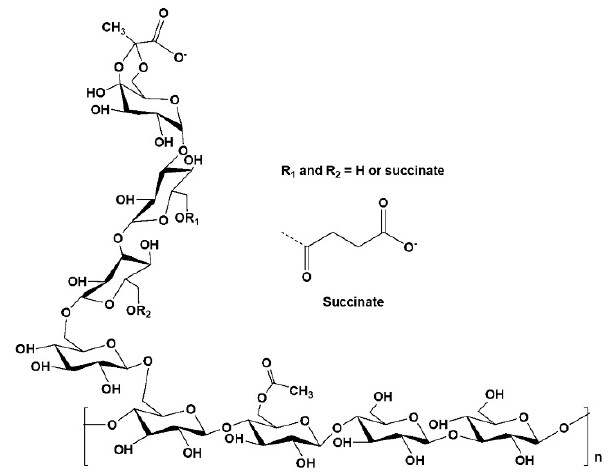
Figure 1. Structure of the succinoglycan repeating unit from S. meliloti Rm 1021.